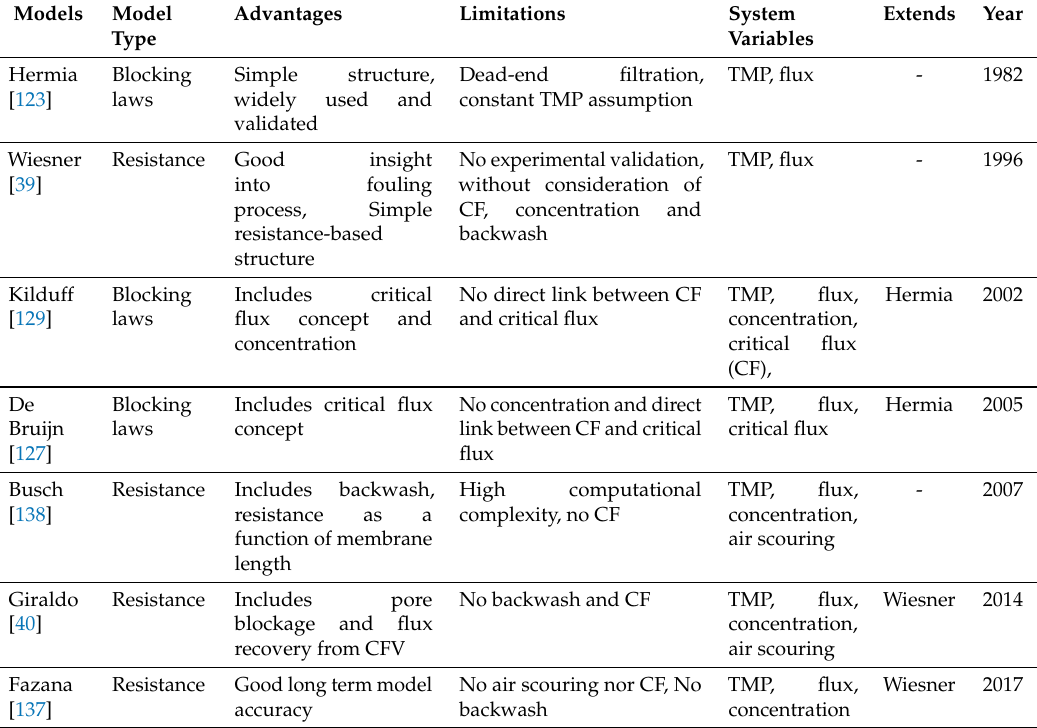
Table 7. Model comparison